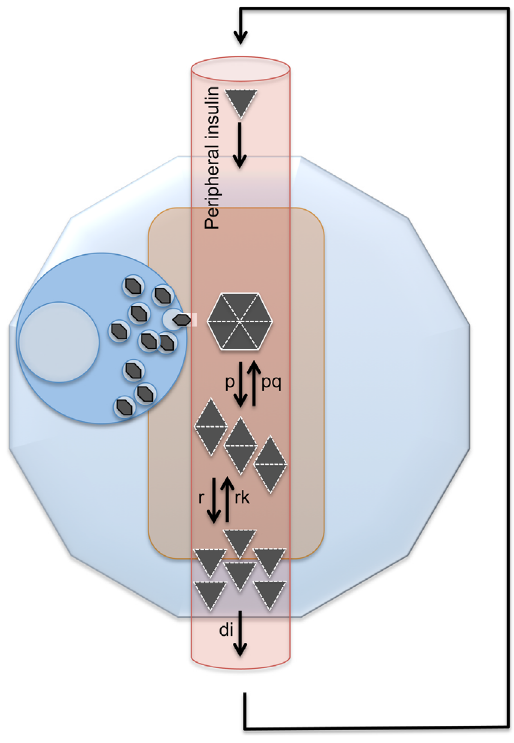
Figure 1. Model diagram for estimation of islet insulin concentration of hexamers, dimers, and monomers. This diagram reflects that, in an intact pancreatic islet, newly synthesized and released hexameric insulin dissolves into dimers and then monomers. Newly released insulin moves out of pancreas into peripheral circulation and then returns the islet with blood flow as ‘old’ peripheral insulin.